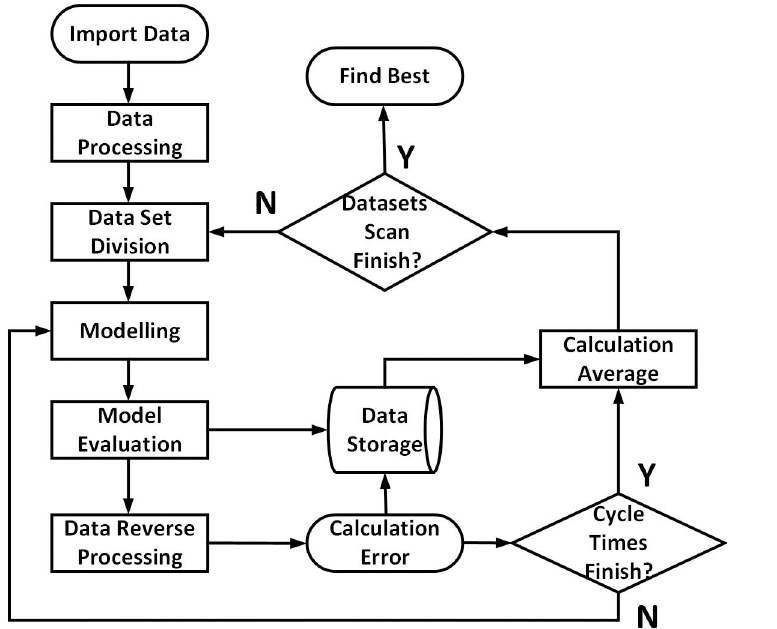
Fig 4. Modeling process of the running-in wear prediction model based on